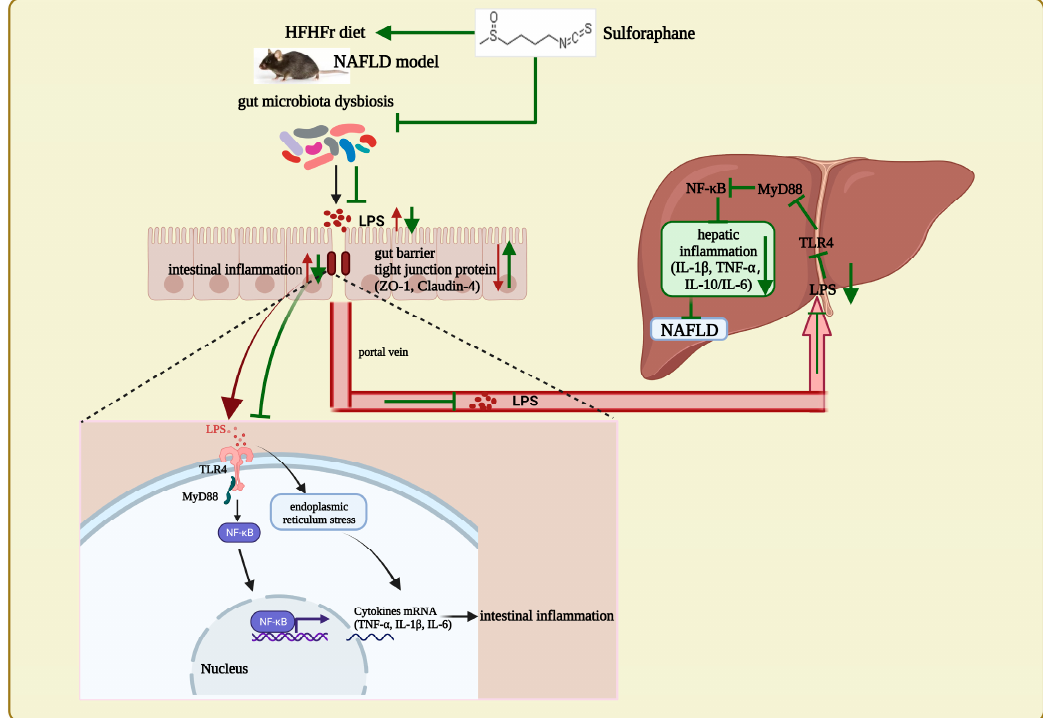
Figure 7. In mice with NAFLD induced by a high ‐ fat, high ‐ fructose diet, SFN supplement improves the compositions of gut microbes, increases the intestinal tight junction protein ZO ‐ 1, reduces serum LPS, and inhibits LPS/TLR4 and ERS pathway to reduce intestinal inflammation. Thus, SFN protects the intestinal integrity in NAFLD mice and declines the gut ‐ derived LPS translocations to the liver. Moreover, SFN reduces the liver LPS level and inhibits the LPS/TLR4 pathway activations, thus inhibiting the pro ‐ inflammatory cytokines and alleviating liver inflammation to improve NAFLD.